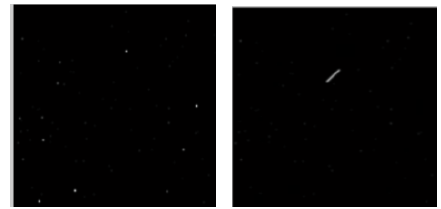
Figure 12. The detected stars (left) and the remained satellite streak (right) The centre of the stars is calculated with a binary mask and sub-pixel accuracy and then used for star identification step.